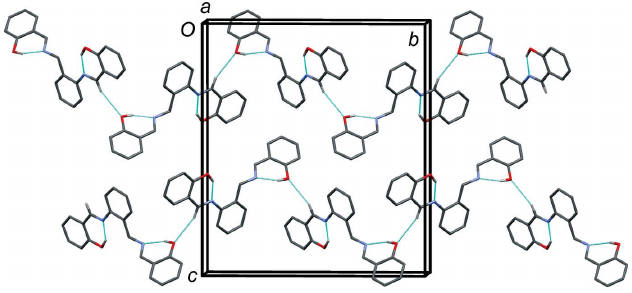
Figure 2 The crystal packing of the title compound, viewed along the a axis. H atoms not involved in hydrogen bonding (dashed lines) have been omitted for clarity.